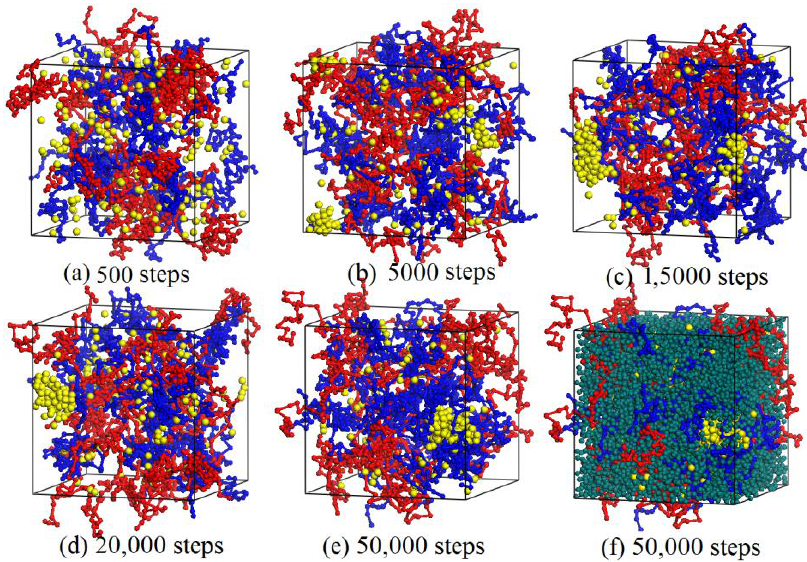
Figure 3. Dynamics process of the aggregation of nano-silica in the 10% PVA/10% PAM/2% nano-silica blended hydrogel system: ( a ) 500 steps; ( b ) 5000 steps; ( c ) 15,000 steps; ( d ) 20,000 steps; ( e ) 50,000 steps; and ( f ) equilibrium model with all beads shown at 50,000 steps. The red, blue and yellow denote PVA, PAM and nano-silica, respectively; and for the rest, dark green denotes water.